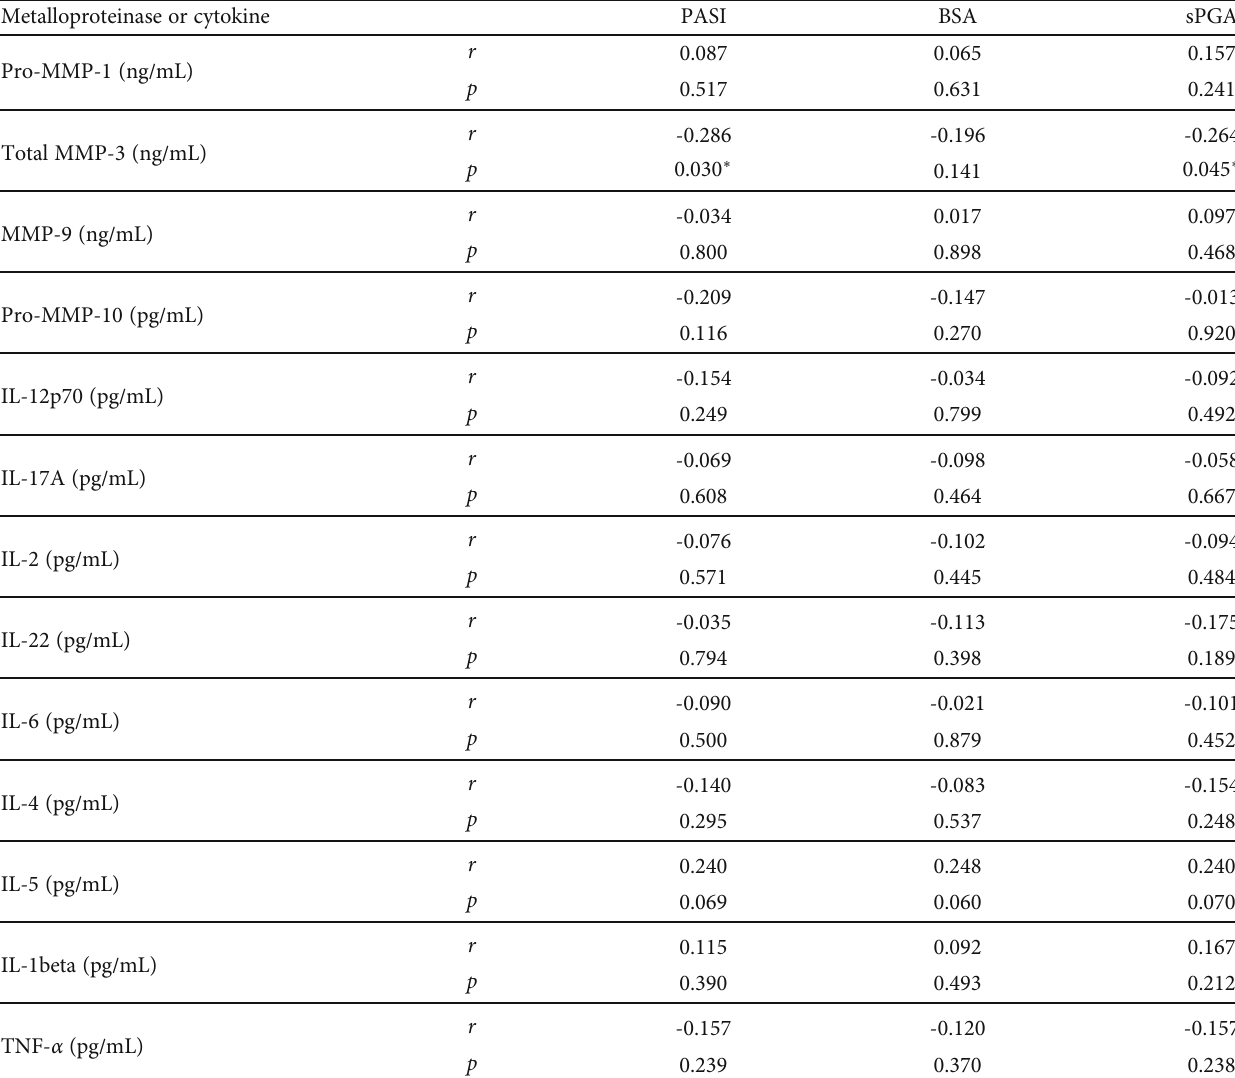
Table 4: Correlations between metalloproteinases and cytokines and severity of psoriasis ( N = 58 ). ∗ indicates statistically signi fi cant di ff